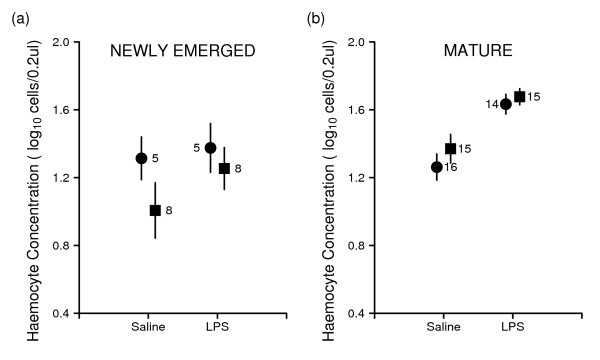
Mean haemocyte concentration (± 1 SE) for males (circle) and females (square) of (a) newly emerged and (b) mature Enallagma boreale 12 h after injection of saline or LPS and held at 22°C. Numbers indicate sample size.